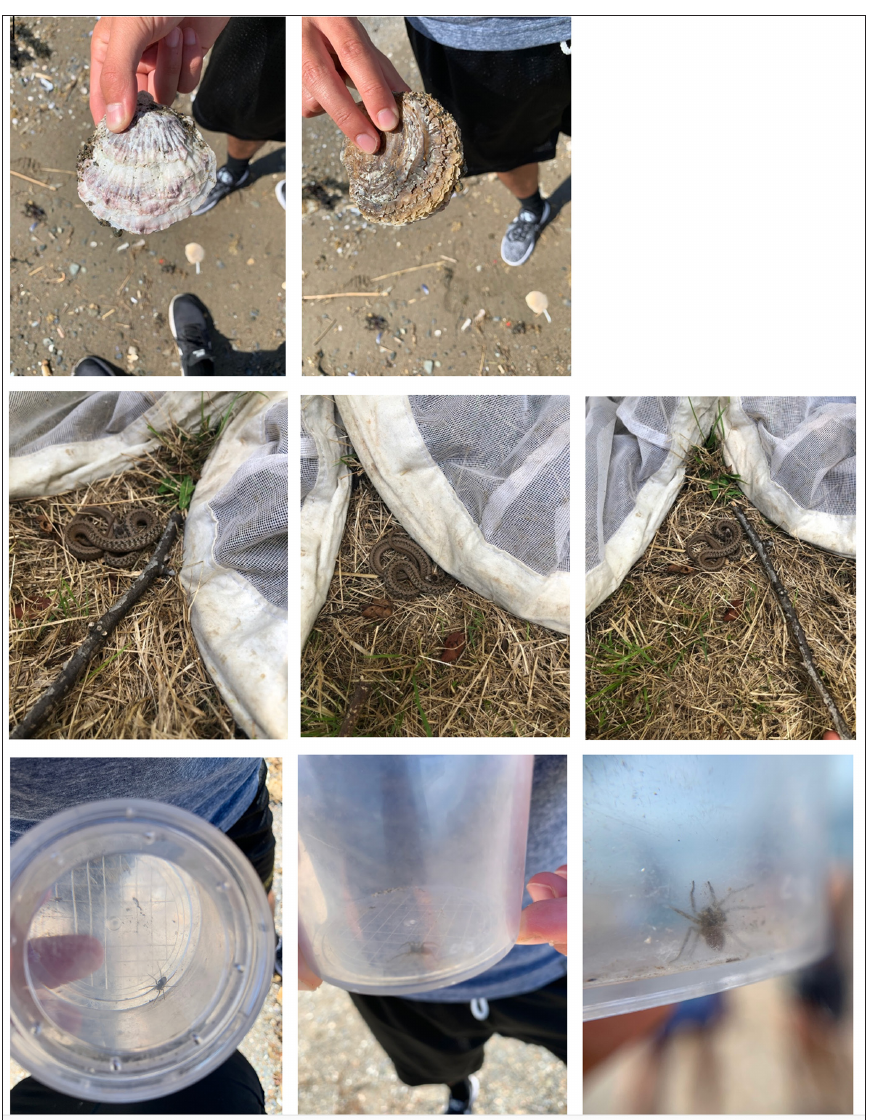
Figure 1 An example of a good ( https://www.inaturalist.org/observations/31739760 ) ( row 1 , an oyster), OK ( https://www.inaturalist.org/ observations/31742210 ) ( row 2 , a snake), and poor ( https://www.inaturalist.org/observations/31740442 ) ( row 3 , a spider) set of images from three different observations. Criteria are based on Table 1. Reasons to score the third-row observation as poor are three more or less identical photographs with nothing specific for scale, with poor focus, and slightly obscured by the plastic container. A similar example is given for plants in Supplemental Figure